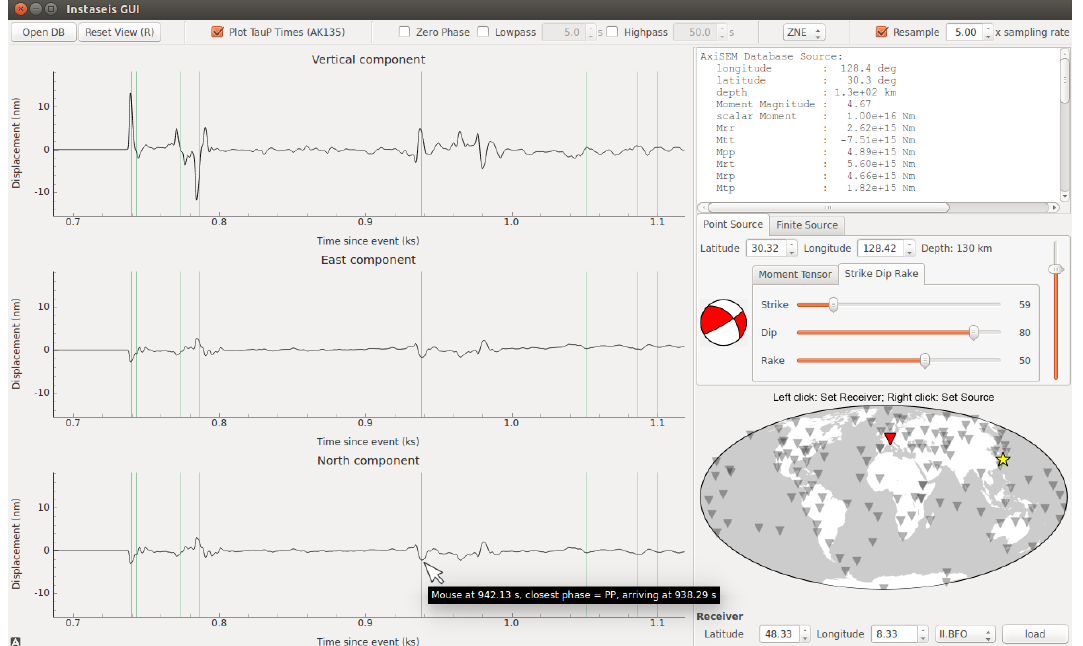
Figure 17. Screenshot of the Instaseis graphical user interface (GUI). Aside from quickly exploring the characteristics of a given Green’s function database it is a great tool for understanding and teaching many features of seismograms. The speed of Instaseis enables an immediate visual response to changing source and receiver parameters. The left-hand side shows three-component seismograms where theoretical arrival times of various seismic phases are overlaid as vertical lines. The bar at the top is used to change filter and resampling settings and the section on the right side is used to modify source and receiver